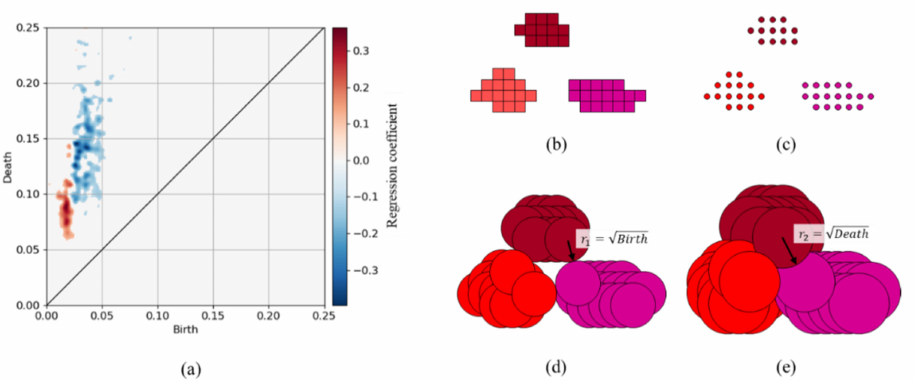
Figure 19. Distribution of the LR coefficient of the aggregate extracted by the CNN on the PD, and schematic illustration of the filler aggregates extracted by the PH method. ( a ) Distribution of the L2 regularized LR coefficient, which reflects the distribution of aggregates. The regression coefficient is positive in the red region and negative in the blue region, which contribute to the positive and negative examples, respectively. ( b ) Aggregates extracted by the CNN. Each rectangle represents a pixel, and each color denotes a filler aggregate. ( c ) Centers of the pixels that constitute filler aggregates. ( d ) r 1 is a representative value of the distance between the filler surfaces because a √ Birth . ( e ) r 2 is a representative size of the filler agglomerate (quadratic loop emerges at r = r 1 = √ Death aggregate) because the loop disappears at r = r 2 =